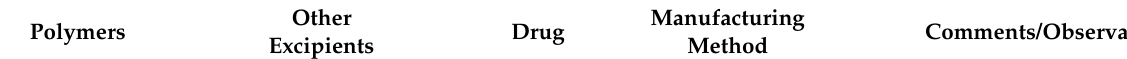
Table 3. Examples of ODFs made on laboratory-scale based on cellulose